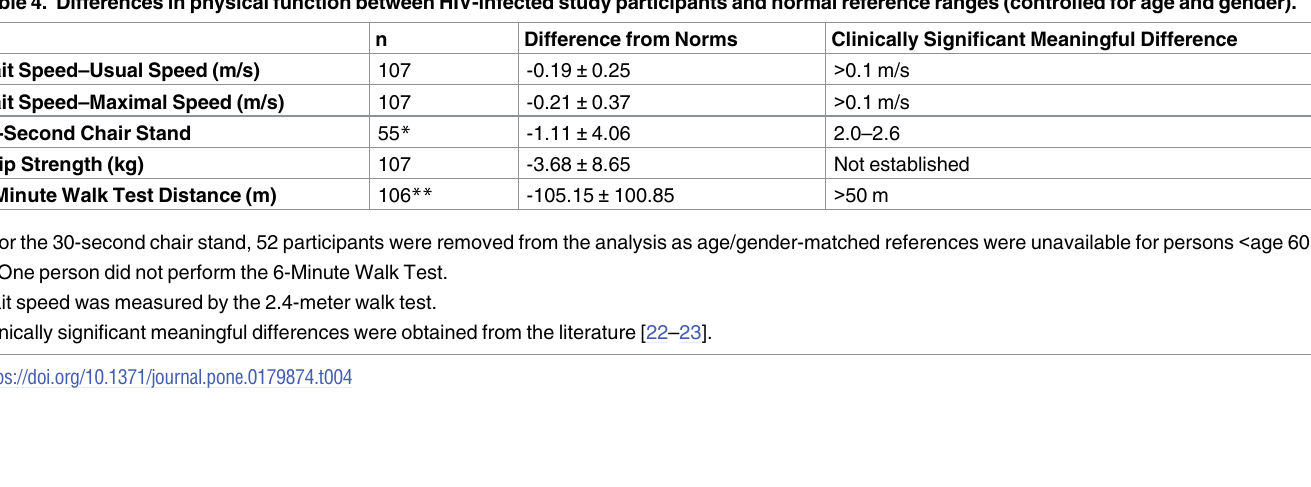
Impact of CD4 nadir on physical function Physical function did not significantly differ between those with a CD4 nadir of < 200 versus > 350 cells/mm 3 (Table 3). There was also no significant difference in physical function between those with a CD4 nadir of < 50 versus > 350 cells/mm 3 .